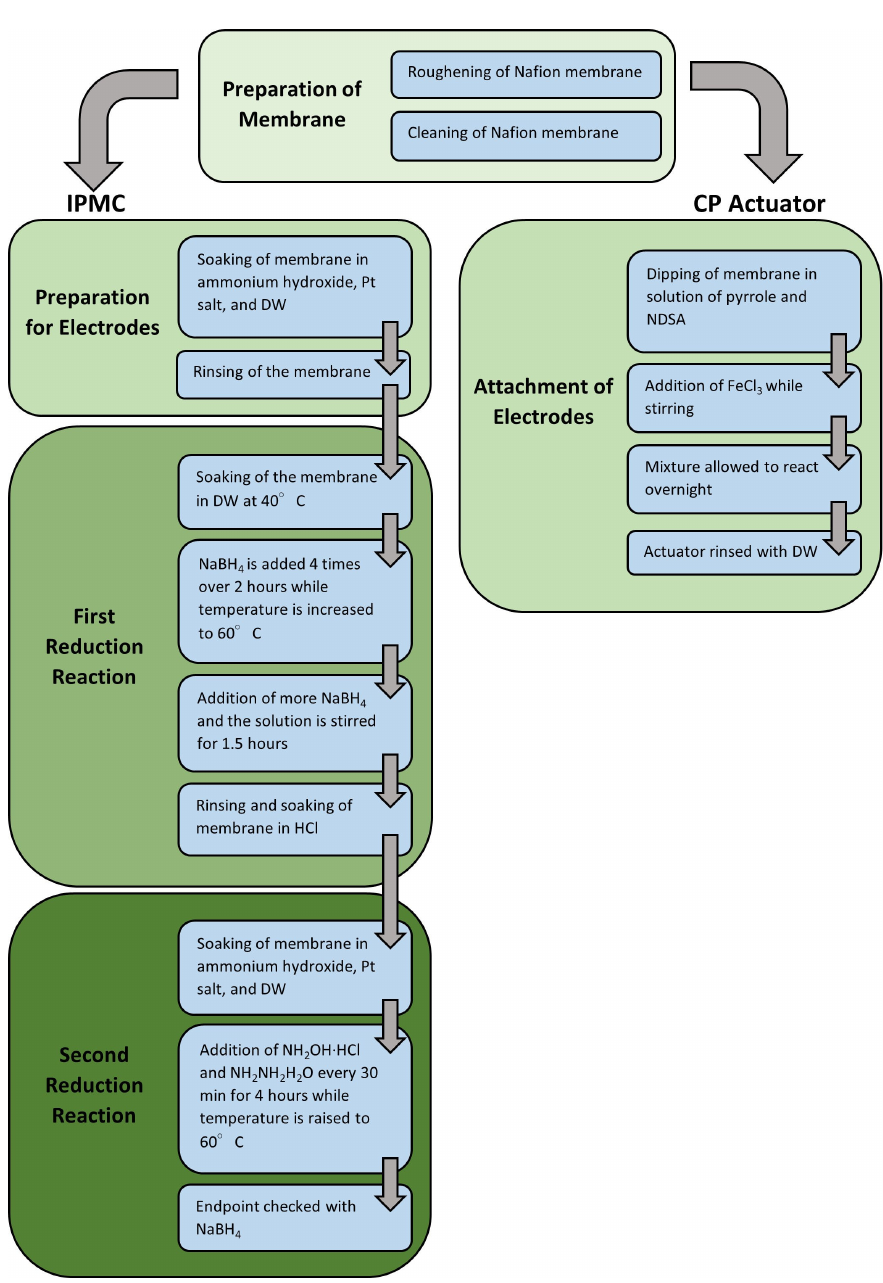
Figure 3. Synthesis steps of IPMC and CP actuator using Nafion ®